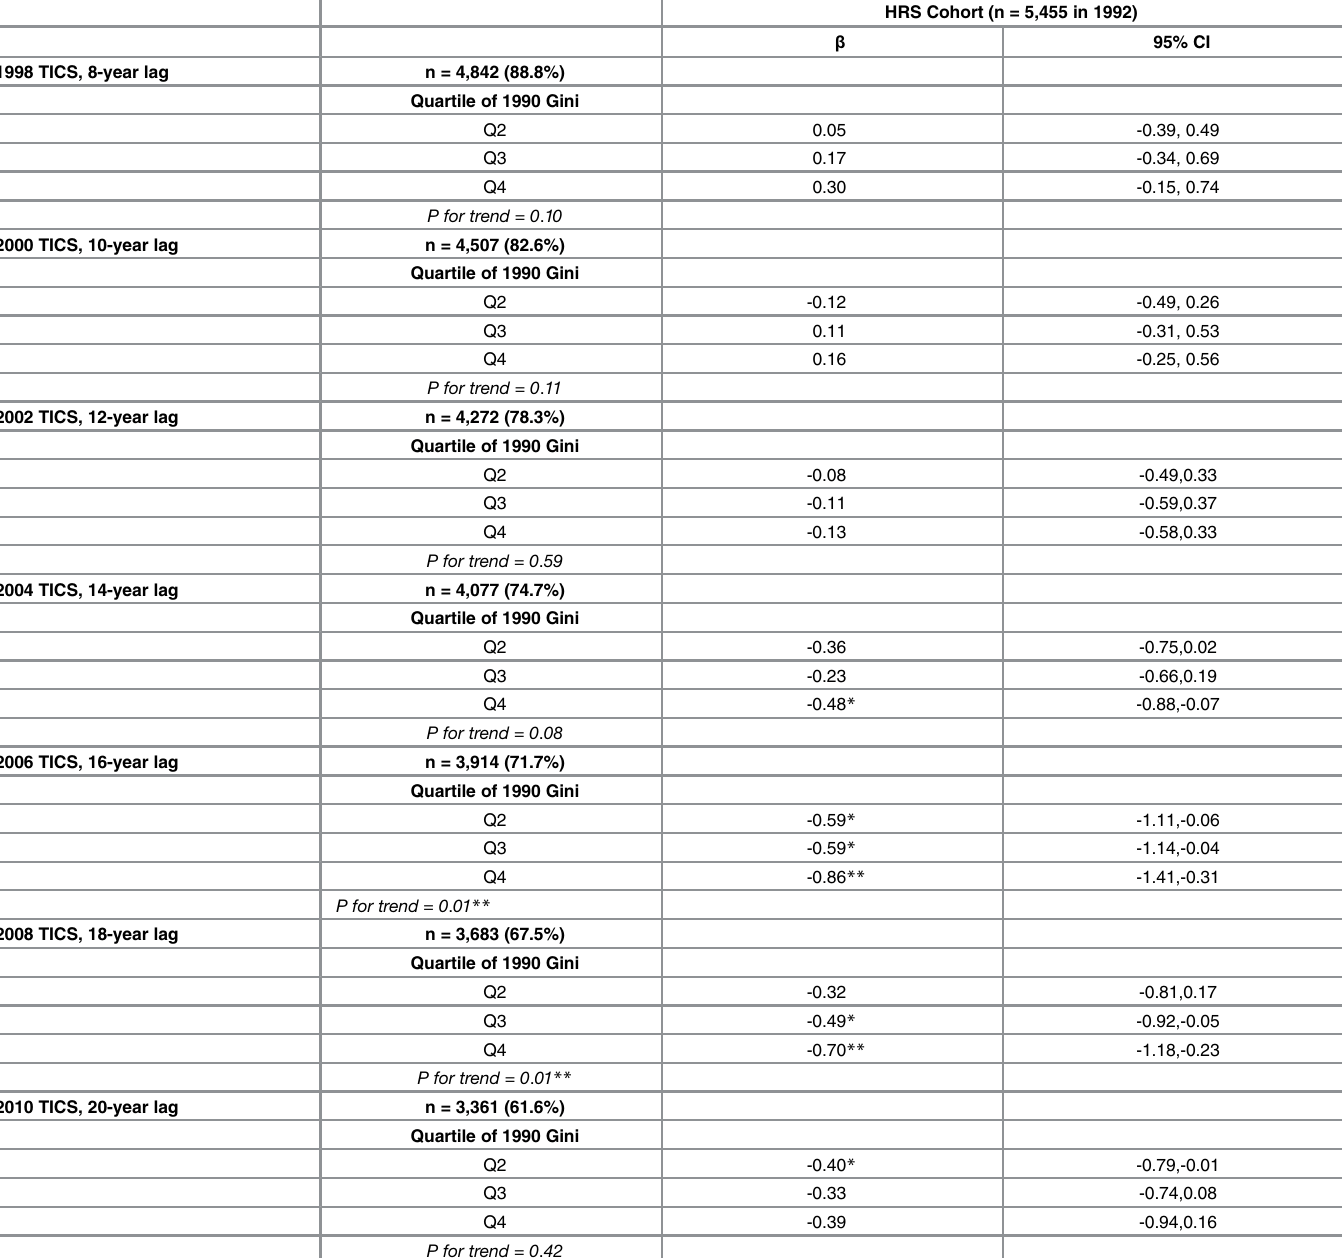
Table 2. Non-response weighted multivariate linear regression coefficient estimates with varying lag periods between the 1990 U.S. MSA-level Gini coefficient and TICS-m score (1998 – 2010), Health and Retirement